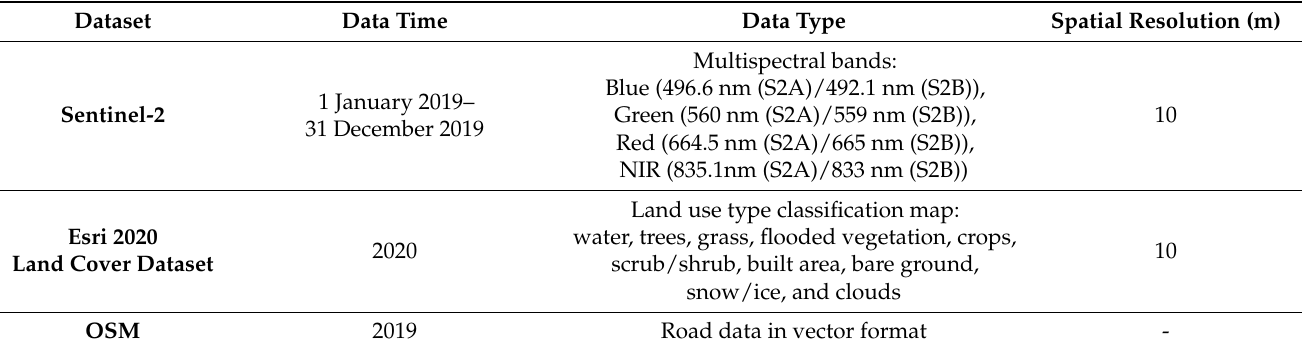
Table 1. Details of the datasets used in this study.